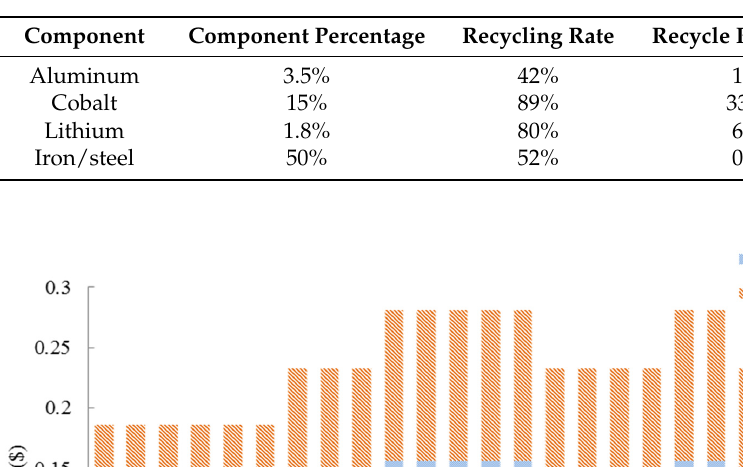
Table 3. Recycling rates and profit for battery materials [46–48]. Figure 11. Active power generating curves of Unit 1, Unit 4 and Units 7–10 in Case 1 and Case 2 with 0.9 confidence degree.